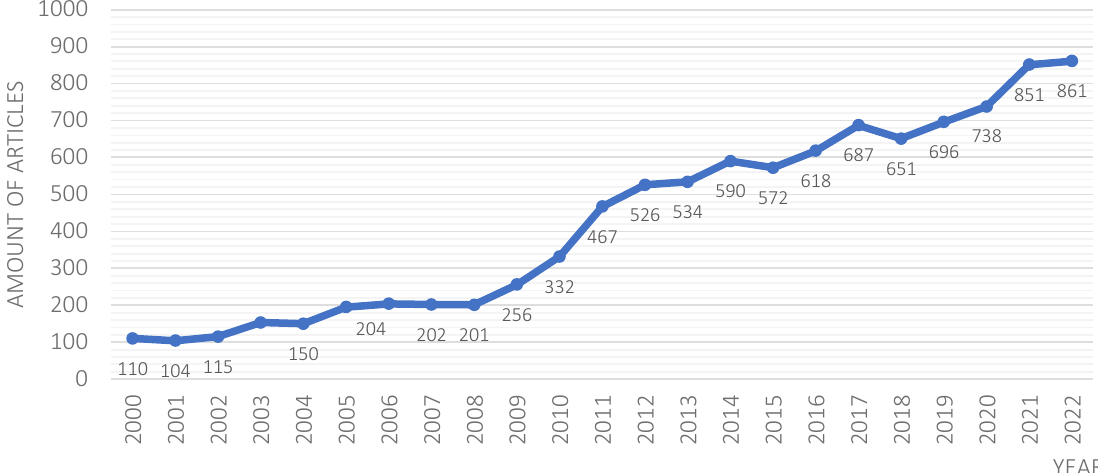
Figure 1. Dynamics of published articles for 2000–2022 concerning public